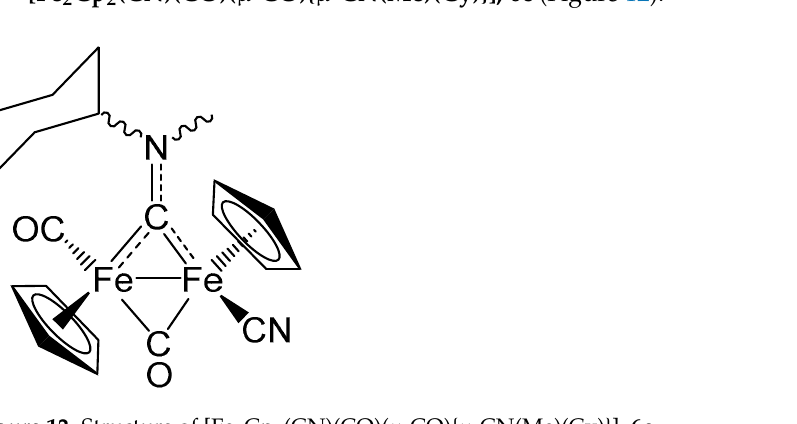
Figure 5. Structure of [Fe 2 Cp 2 (k N- NCO)(CO)(µ-CO){µ-CN(Me)(Me)}], 2b [39].